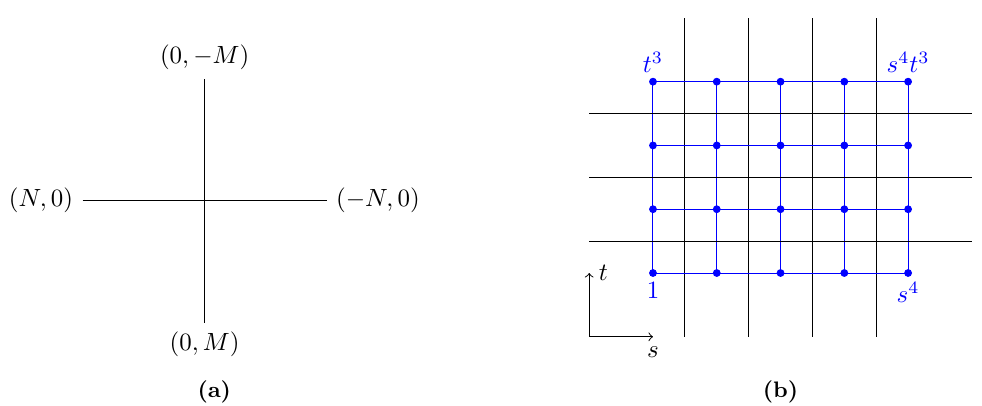
Figure 4. Left: the 5-brane junction describing the + N;M SCFT. Right: brane web and grid diagram for a mass deformation of the + 3 ; 4 theory (a complete triangulation of the grid diagram can be obtained by resolving the remaining brane